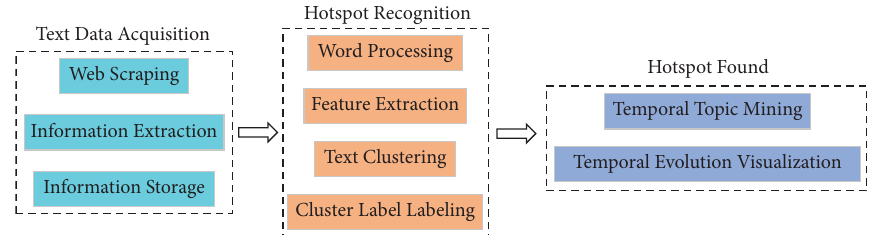
Figure 1: Data processing fow of hotspot discovery